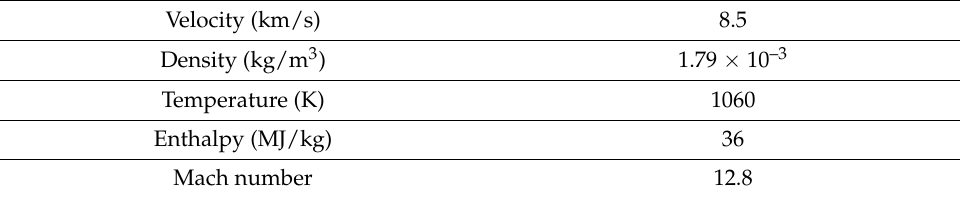
Figure 38. Power density comparison between EAST and X2 for Mars conditions and 0.1 Torr (datasets from X2 are those with the name starts by x2 in the legend) (from [34]). Other similar conditions with a shock velocity higher than 8 km/s have been investi- gated in [37]. Test conditions are reported in Table 2 and corresponding results in Figure 39. Measurements were again concentrated on the CN violet system. Table 2. Test in X2 for a Mars-like mixture (96% CO 2 , 4% N 2 ): Calculated free stream conditions in